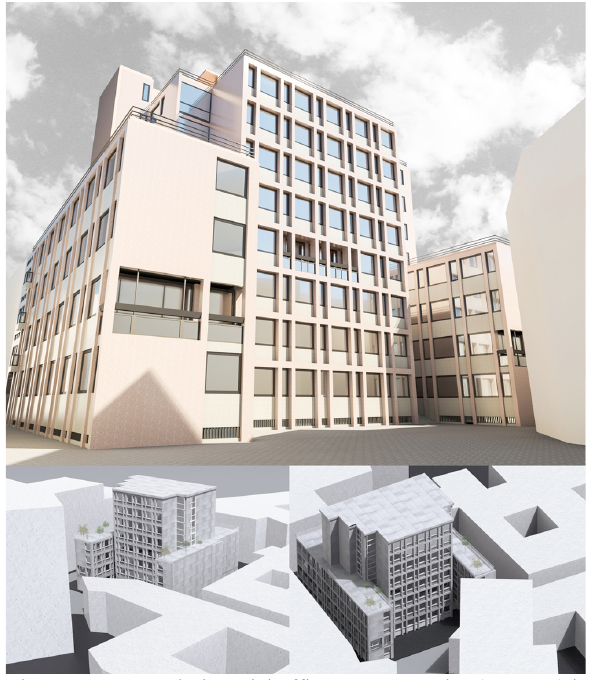
Figure 12 – Central Financial offices “La Centrale” (1954-55) in Milan, Italy (architects P. Lingeri, P. G. Bosisio, U. Busca, G. Casalis and C. Maltini). Architectural Model. Course